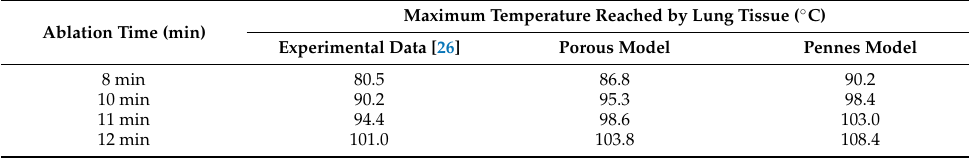
Table 3. Maximum temperature of lung tissue under different conditions.